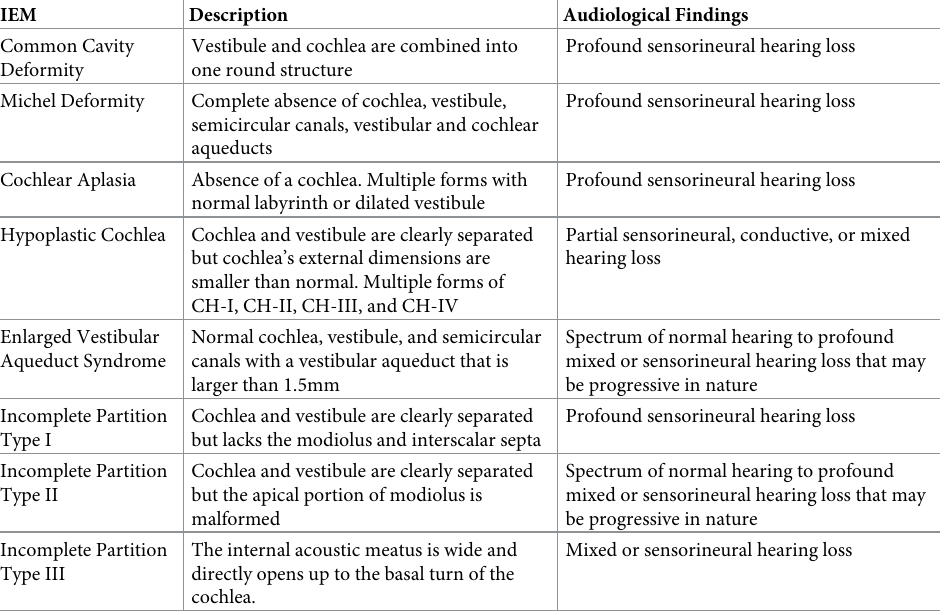
Table 1. Descriptions and audiological findings in individuals with IEMs